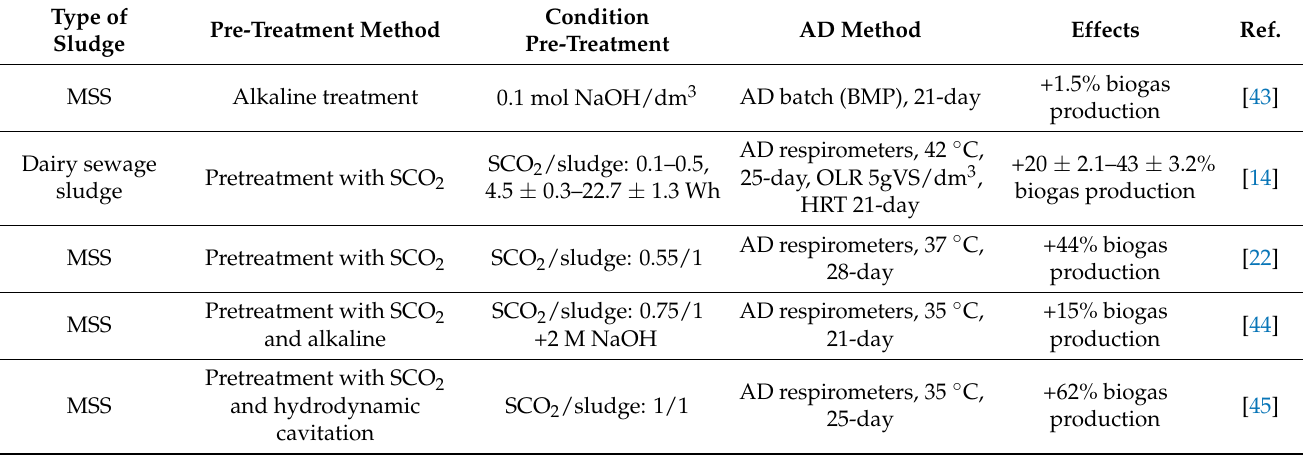
3.3. Organic Matter and Digestion Coefficient Stage V1 and V2 produced the lowest levels of VS in the digestate. The levels for S1 were 64.6 ± 0.9% TS and 64.5 ± 0.8% TS, respectively. The S2 digestate contained 63.6 ± 0.6% TS (V1) and 63.9 ± 0.7% TS (V2) (Figure 5a). Increasing OLR to 5.0 gVS/dm 3 ·day led to significantly higher rates of VS in the digestate, i.e., 70.2 ± 1.2% TS in S1 and 67.6 ± 1.4% TS in S2 (Figure 5a). There was a positive linear relationship between the OLR and VS removed. The biodegradation rate in S1V1 was 25.4 ± 0.2 gVS/day, which corresponded to 63.3% of the initial load (Figure 5b). Similarly, the mineralization rate in S2V1 was 67.1%, which translated to 26.8 ± 0.4 gVS removed per day (Figure 5b). At an OLR of 5.0 gVS/dm 3 · d (V4), the removal rates were 54.6 ± 1.2 gVS/day (43.4%) in S1 and 58.7 ± 1.3 gVS/day (47.9%) (Figure 5b). The VS mineralization rate was somewhat affected by the pre-treatment with SCO 2 , but OLR was the main determinant.